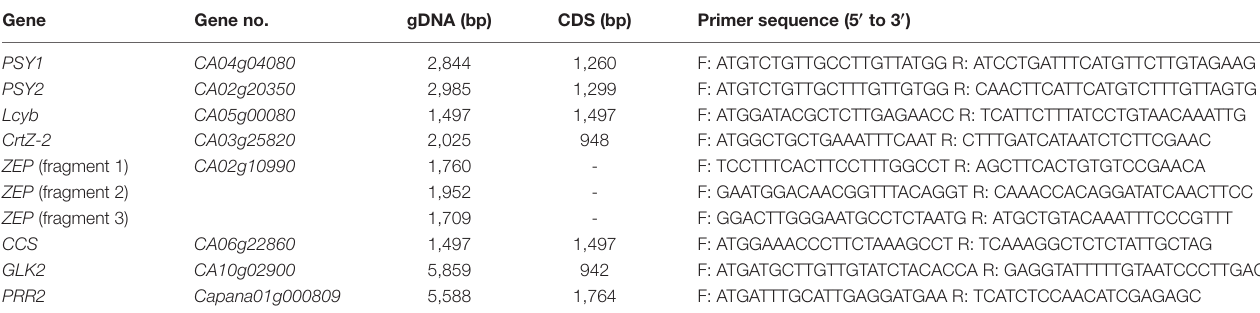
TABLE 1 | List of primers used to amplify fruit-color-related genes. Gene Gene no. gDNA (bp) CDS